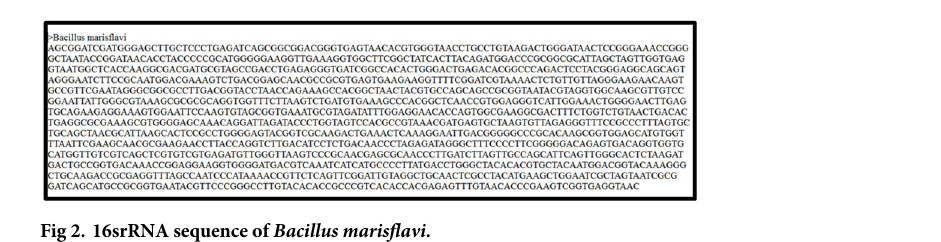
Fig 2. 16srRNA sequence of Bacillus marisflavi .